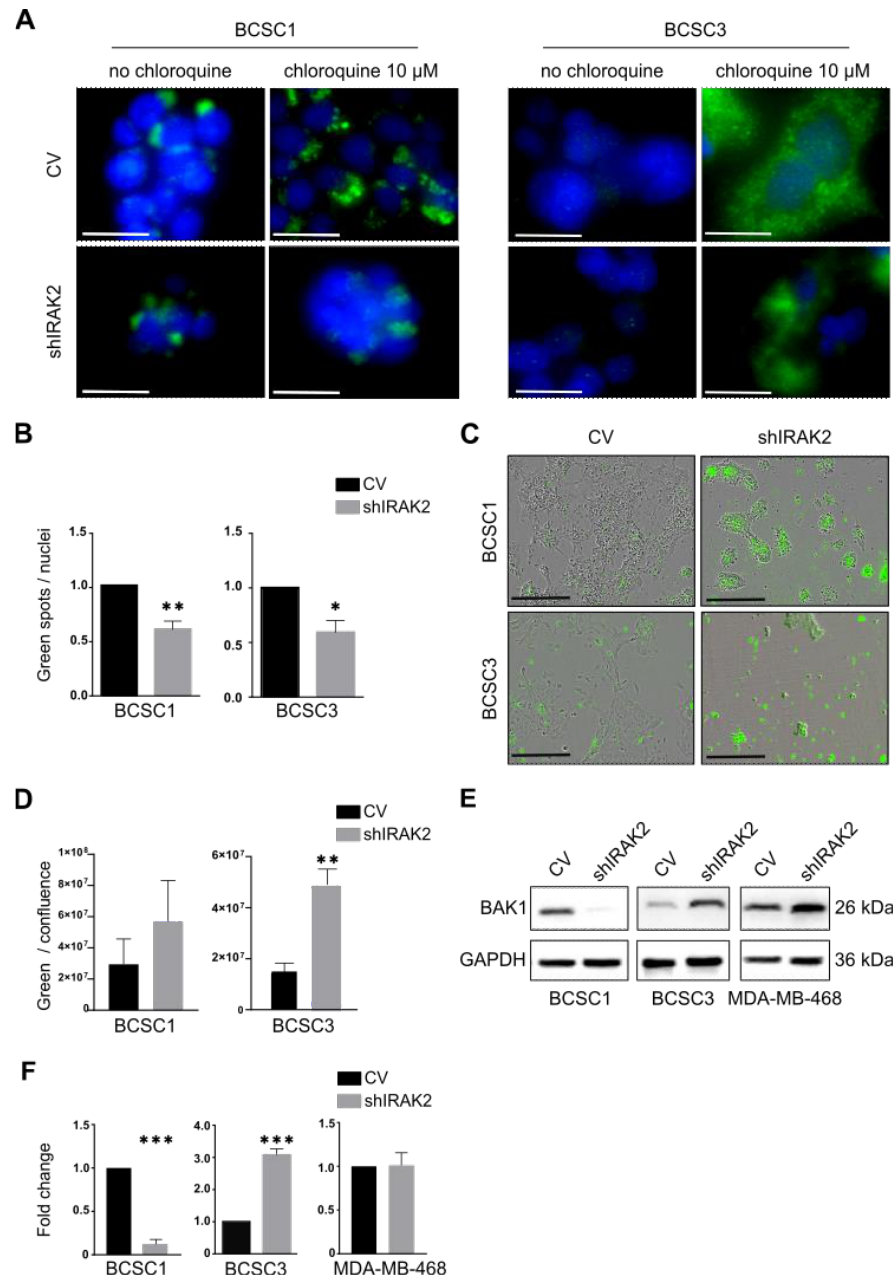
Figure 4. IRAK2 knockdown decreases autophagy in BCSC1 and BCSC3 and induces apoptosis in BCSC3. ( A ) Immunofluorescence staining (green fluorescence) of LC3-II in control (CV) and IRAK2- induced knockdown (shIRAK2) BCSC1 and BCSC3 cells treated with chloroquine (chloroquine 10 µM) or not (no chloroquine). 4 ’ ,6-diamidino-2-phenylindole allowed visualisation of the nuclei in blue. Cells were cultured for 5 days in a medium supplemented with 100-ng/mL doxycycline, treated overnight with 10-µM chloroquine and fixed, and LC3-II immunofluorescence staining was performed. Scale bars represent 25 µm. ( B ) Autophagy was quantified considering the ratio between the counted green spots representing the LC3-II over the number of nuclei counted per picture. ( C ) Representative pictures of phosphatidylserine (PS) externalisation (green fluorescence) in CV and